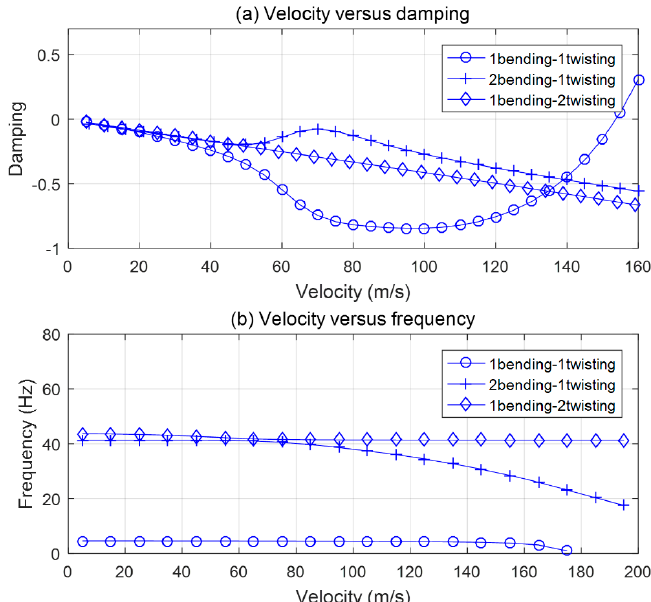
Figure 2. First three bending-twisting modes of the wing covered by PZTs layers with 50,000 Ω load resistance. ( a ) Damping evolution with increasing flow velocity; ( b ) frequency evolution with increasing flow velocity.